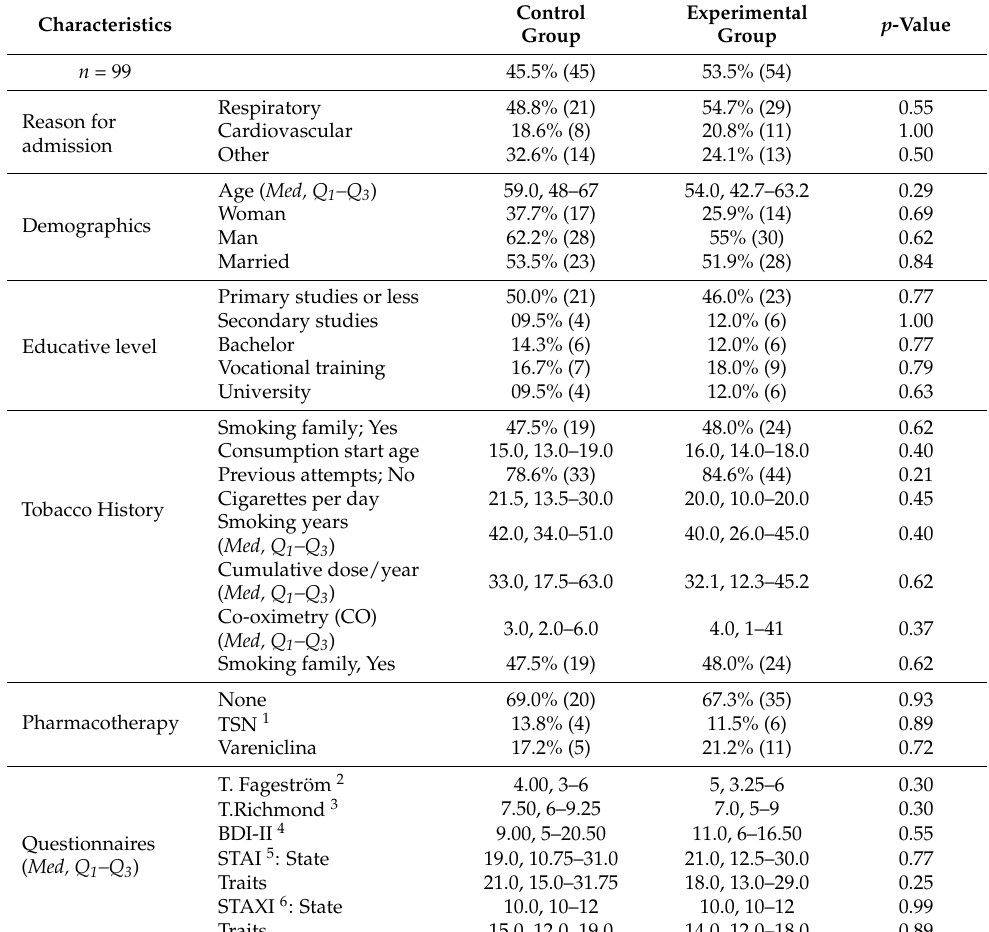
Table 2. Baseline characteristics of both control and experimental groups, and comparison tests significance p